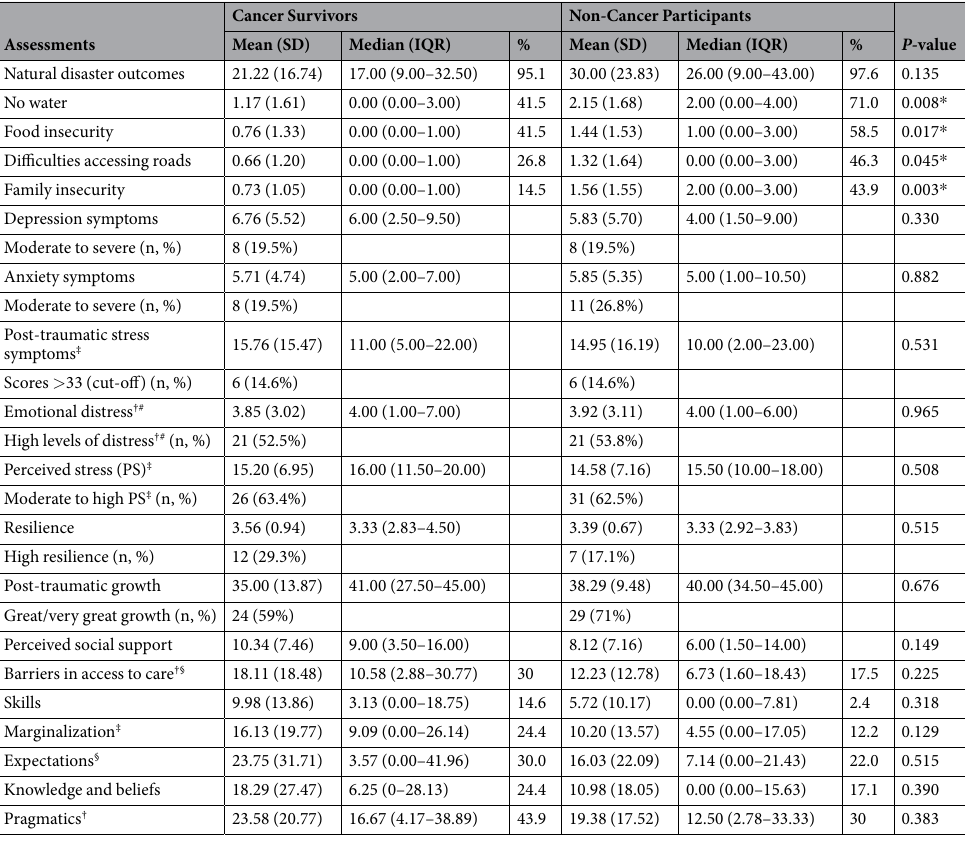
Table 2. Psychosocial measurements from study participants. % expressed as percent of participants that were affected by each variable on the NDO and Barriers in Access to Care questionaires; ‡ Non-Cancer, n = 40; † Non- Cancer, n = 39; § Cancer, n = 40; # Cancer, n = 40, * Significant Differences: p <